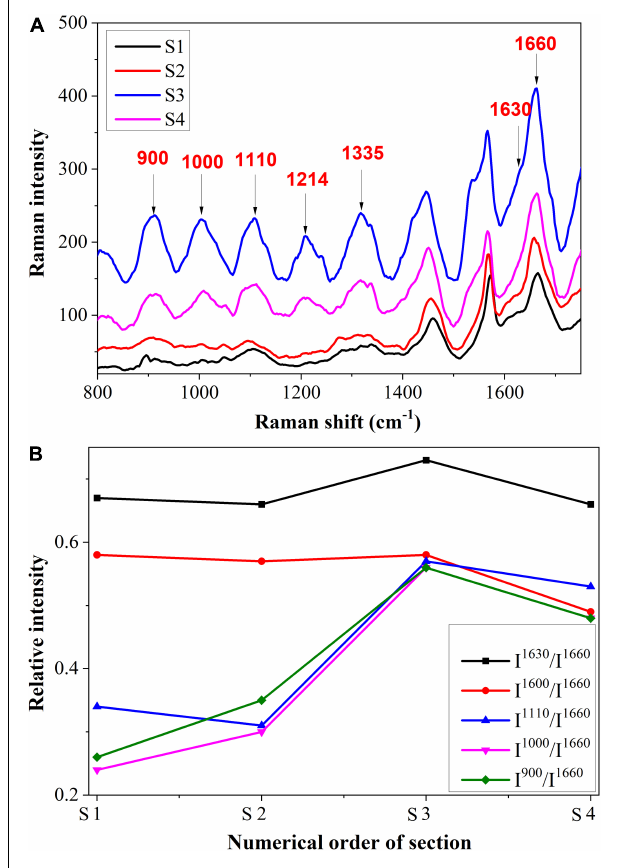
FIGURE 8 | (A) Raman spectroscopy and (B) Semi-quantitative intensity analysis of